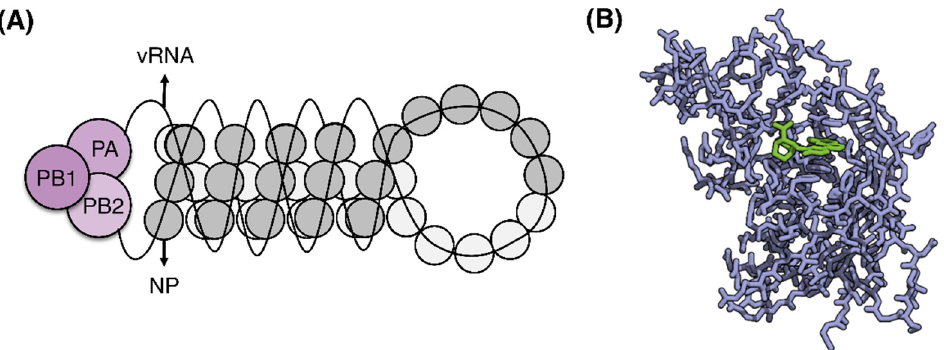
Figure 3. Polymerase basic protein 2 (PB2) subunit. ( A ) Ribonucleoprotein (RNP) complex comprising of the heterotrimeric complex (PB1, PB2, and PA), nucleoprotein (NP) and viral RNA (vRNA). ( B ) Influenza A (A/California/07/2009(H1N1)) PB2 complexed with Pimodivir, VX-787 (in green, PDB 7AS0 [42] ) modified with QuteMol [46] .